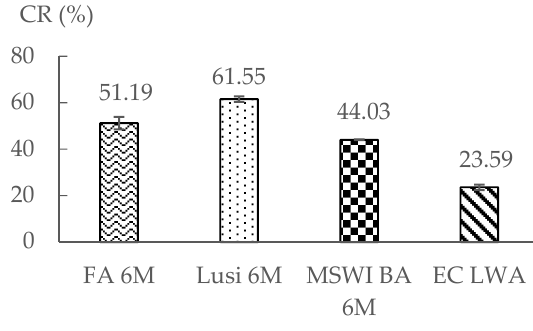
Figure 6. Crushing resistance (CR) value of LWA.